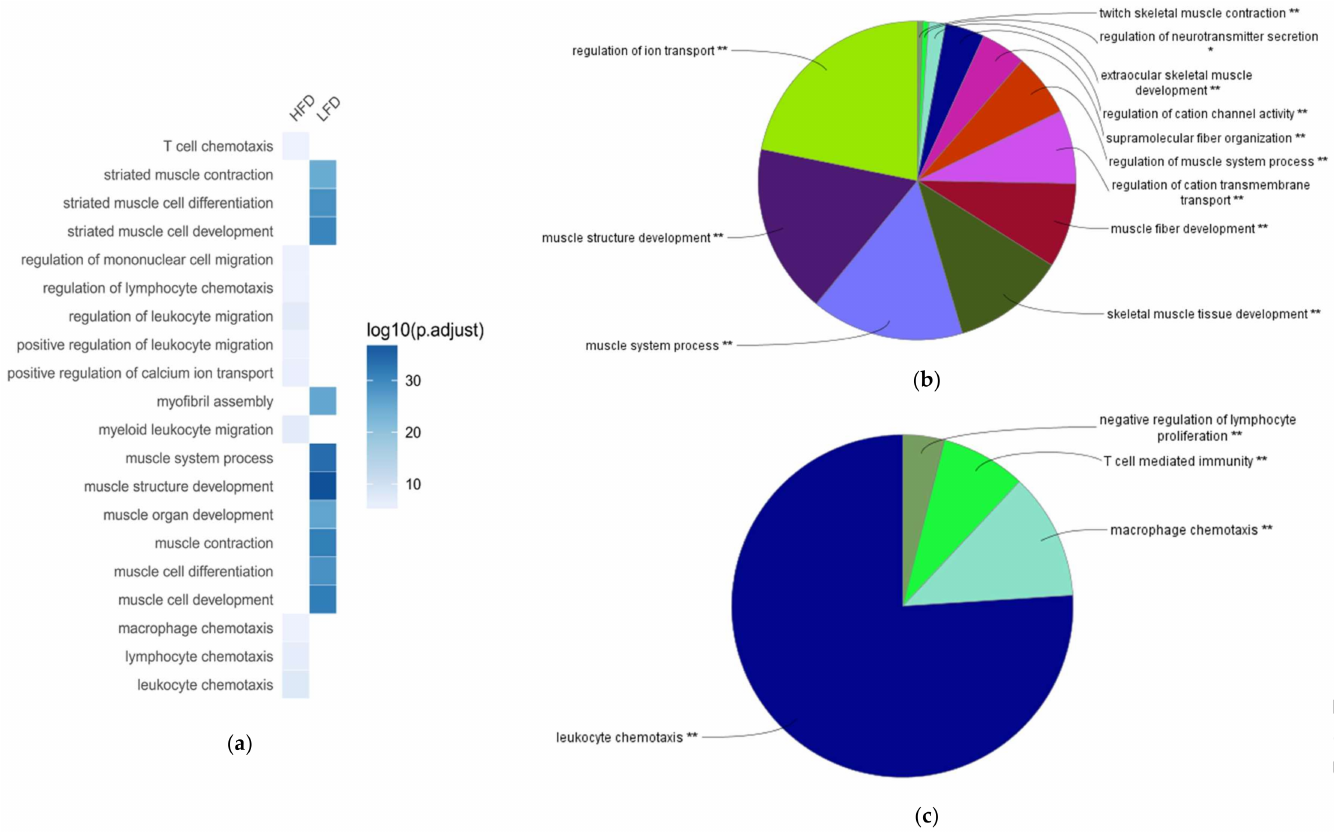
Figure 2. Comparing top Gene Ontology (GO) biological process (BP) terms associated with high-fat diet (HFD)-responsive genes in brown adipose tissue (BAT). Enrichment analysis was performed using differentially expressed genes in BAT between HFD and low-fat diet (LFD) groups. ( a ) Heat-map showing top GO BP annotation terms in the BAT between HFD and LFD groups. ( b ) GO BP terms associated with downregulated genes in BAT of HFD-fed obese mice. ( c ) GO BP terms associated with upregulated genes in BAT of HFD-fed obese